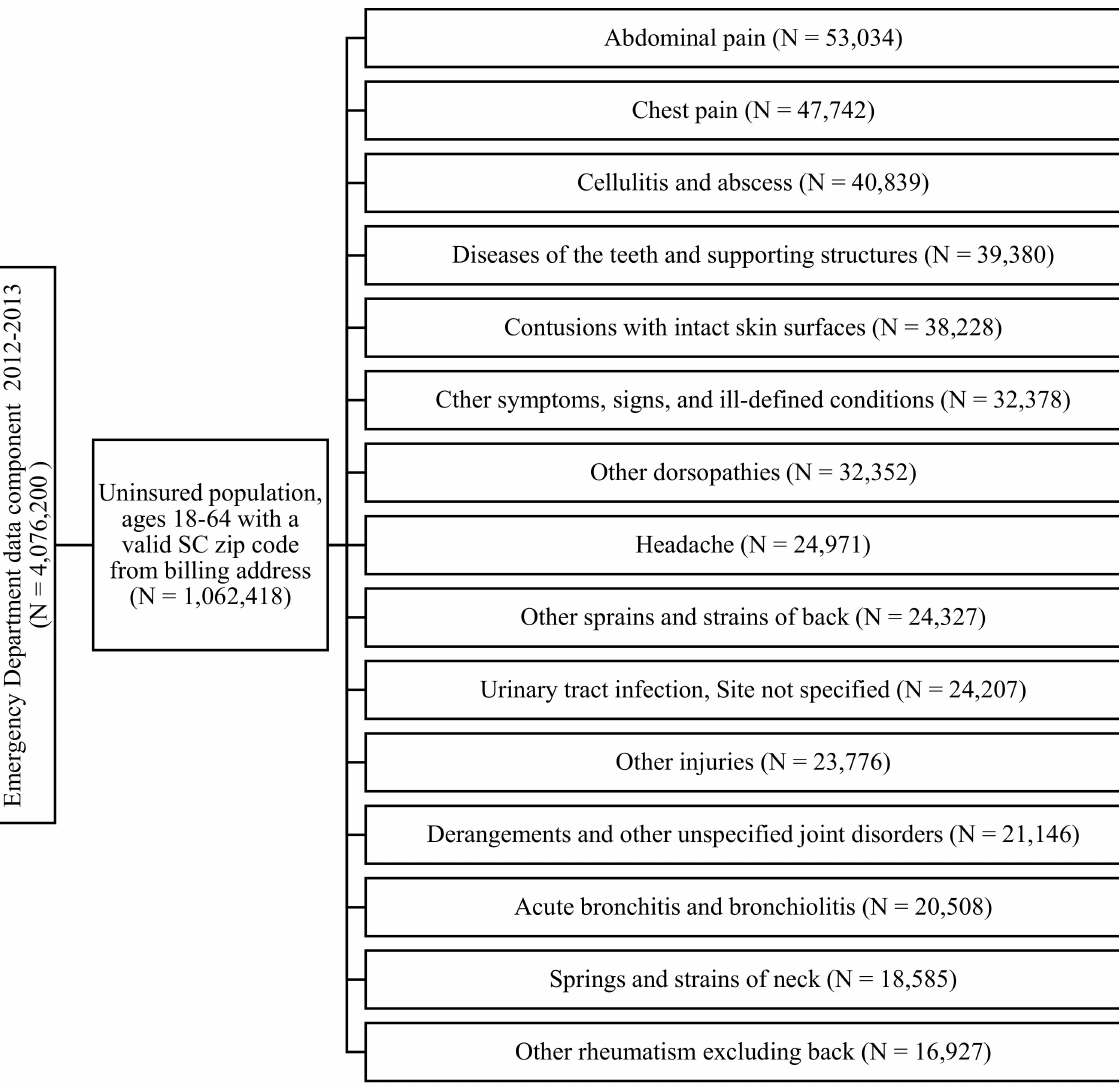
Figure 1. Data management flow